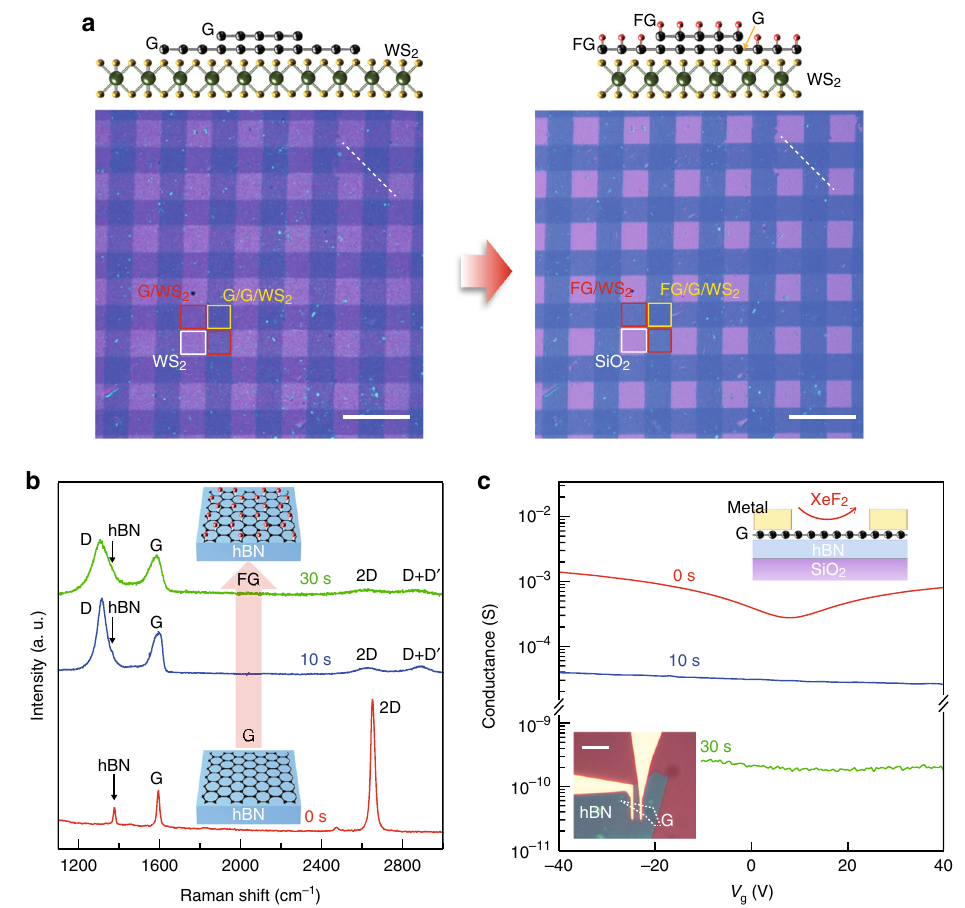
Fig. 2 Raman and conductance measurements of fl uorinated graphene. a Optical images (bottom) of CVD WS 2 sheet covered with prepatterned CVD GES before and after XeF 2 etching (the scale bar is 50 μ m). Schematic illustrations (top) show cross-section of graphene-covered WS 2 along white dashed lines for each step. After etching, uncovered WS 2 is etched away, meanwhile the covered WS 2 remains unchanged under protection of fl uorinated GES. b Raman spectra of graphene on hBN under increasing exposure to XeF 2 . As XeF 2 exposure time increases, the graphene D peak becomes prominent while the 2D peak is damped, indicating the formation of sp 3 -type defects. These results are consistent with other studies of graphene fl uorination. c Electrical conductance of graphene on hBN fl uorinated by XeF 2 treatment (the scale bar in the inset is 10 μ m). After a 30 s XeF 2 exposure, FG becomes